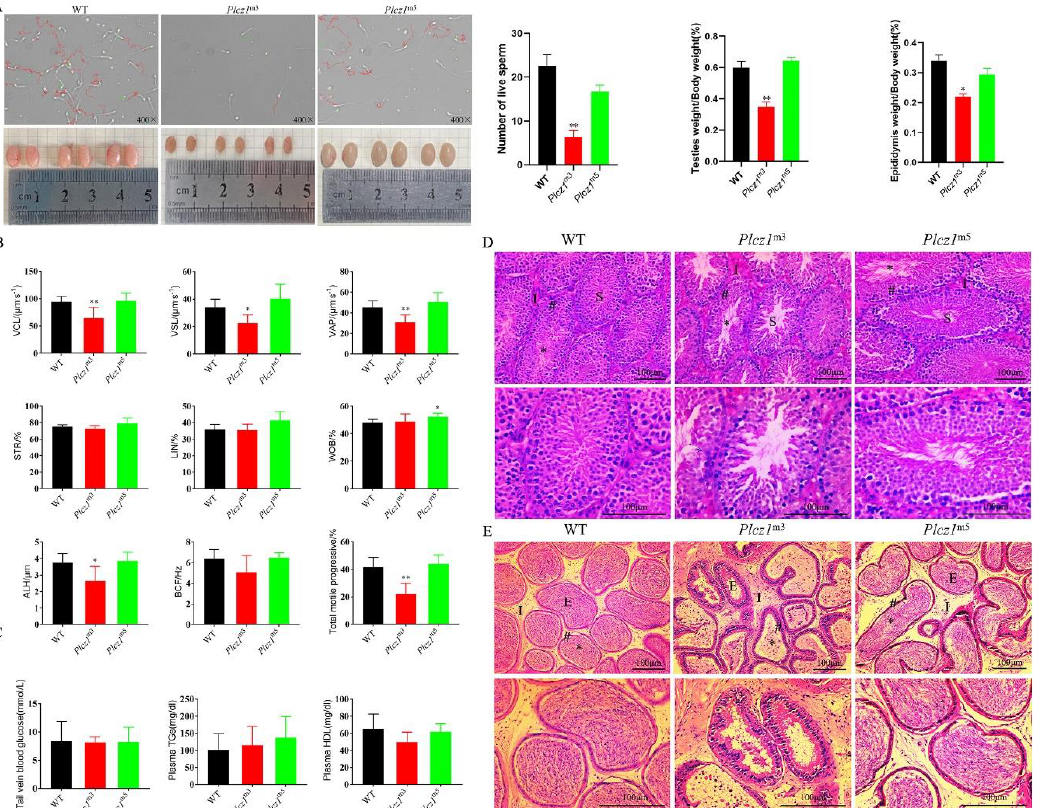
Figure 3. Characterisation of sperm and histopathological changes of testis and epididymis. ( A ) Morphological changes of sperm from Plcz1 m3 and Plcz1 m5 observed under a microscope: red indicates active sperm, green indicates inactive sperm, and yellow indicates impurities. The number of live sperms was statistically analysed by using GraphPad prism 8. In addition, the relative weight of testes and epididymis from Plcz1 m3 and Plcz1 m5 was measured (* p < 0.05, ** p < 0.01). ( B ) Sperm motility parameters were analysed with computer-assisted sperm analysis (CASA). VCL, curvilinear velocity; VSL, straight-line velocity; VAP, average path velocity; STR, straightness; LIN, linearity; WOB, wobble; ALH, amplitude of lateral head displacement; BCF, beat-cross frequency (* p < 0.05, ** p < 0.01). ( C ) Lipids and glucose assay were performed by using the kits. Histological analysis of ( D ) testes and ( E ) epididymis sections after stained with haematoxylin/eosin (HE). (For testes: S, seminiferous tubules; I, testicular stroma; *, seminiferous lumen; #, seminiferous tubule wall. For epididymis: E, epididymal canal; I, epididymal stroma; *, sperm mass; #, epididymal canal